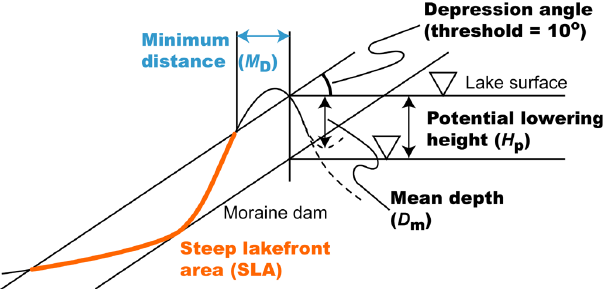
Fig. 1. The concept of the steep lakefront area (SLA), potential low- ering height ( H p ), mean depth ( D m ), and minimum distance ( M D ) for a glacial lake. The threshold angle (10 ◦ ) used to define the SLA was obtained by evaluating pre-GLOF topography in Hexagon KH- 9 images (Fig.